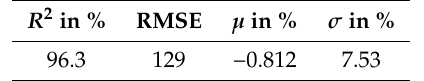
Table 4. Quality parameters of the correlation according to (Equation